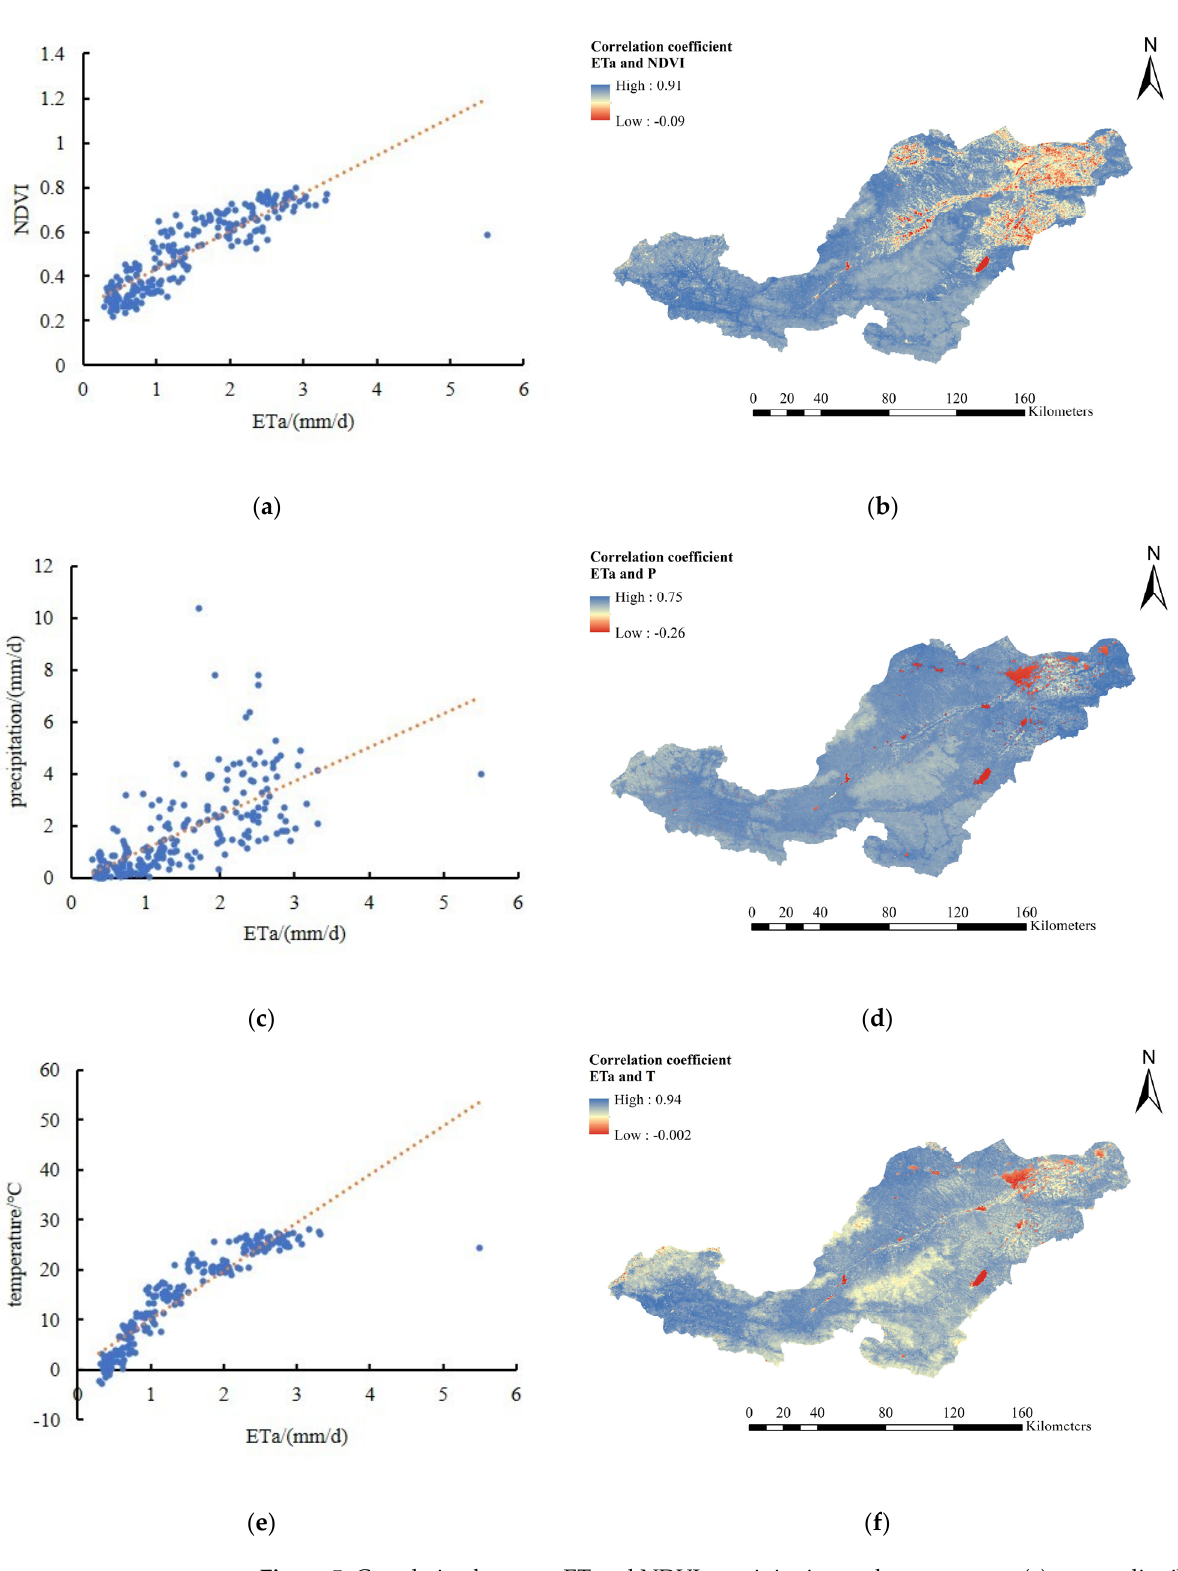
Figure 5. Correlation between ET and NDVI, precipitation and temperature: ( a ) scatter distribution of correlation between ET and NDVI; ( b ) spatial distribution of correlation coefficient between ET and NDVI; ( c ) scatter distribution of correlation between ET and p ( d ) spatial distribution of correlation coefficient between ET and p; ( e ) scatter distribution of correlation between ET and T; ( f ) spatial distribution of correlation coefficient between ET and T.